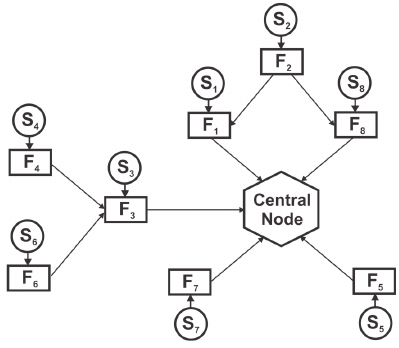
Figure 2. Distributed fusion architecture. Each node consists of sensor and fusion node.